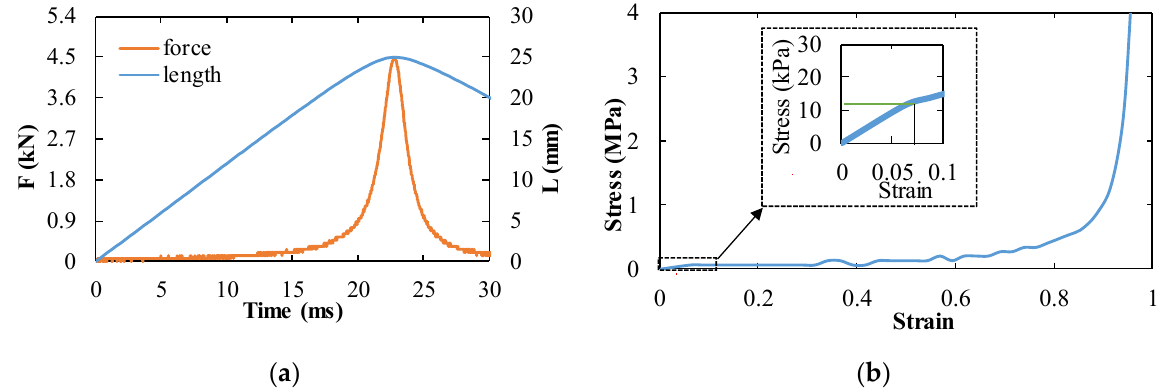
Figure 7. The mechanical response characteristics of the foam in intermediate experiments under a strain rate of 40 s − 1 : ( a ) drop tower test curve corresponding to the displacement, force, and time of the experiment, the orange line represents the force of the specimen, and the blue line represents the compression displacement of the specimen; ( b ) the strain–stress curve of the foam in the drop tower experiments, here, the yield stress is 0.0109 MPa.